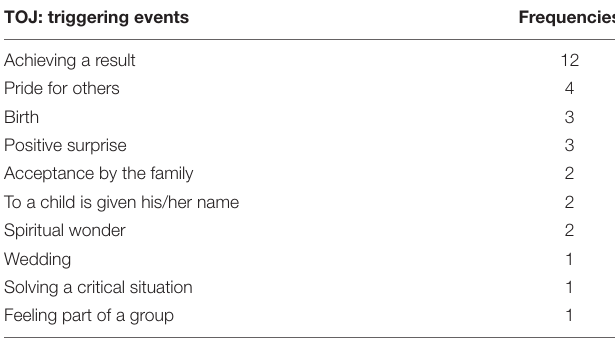
TABLE 2 | Frequencies of coded category “Triggering events”.